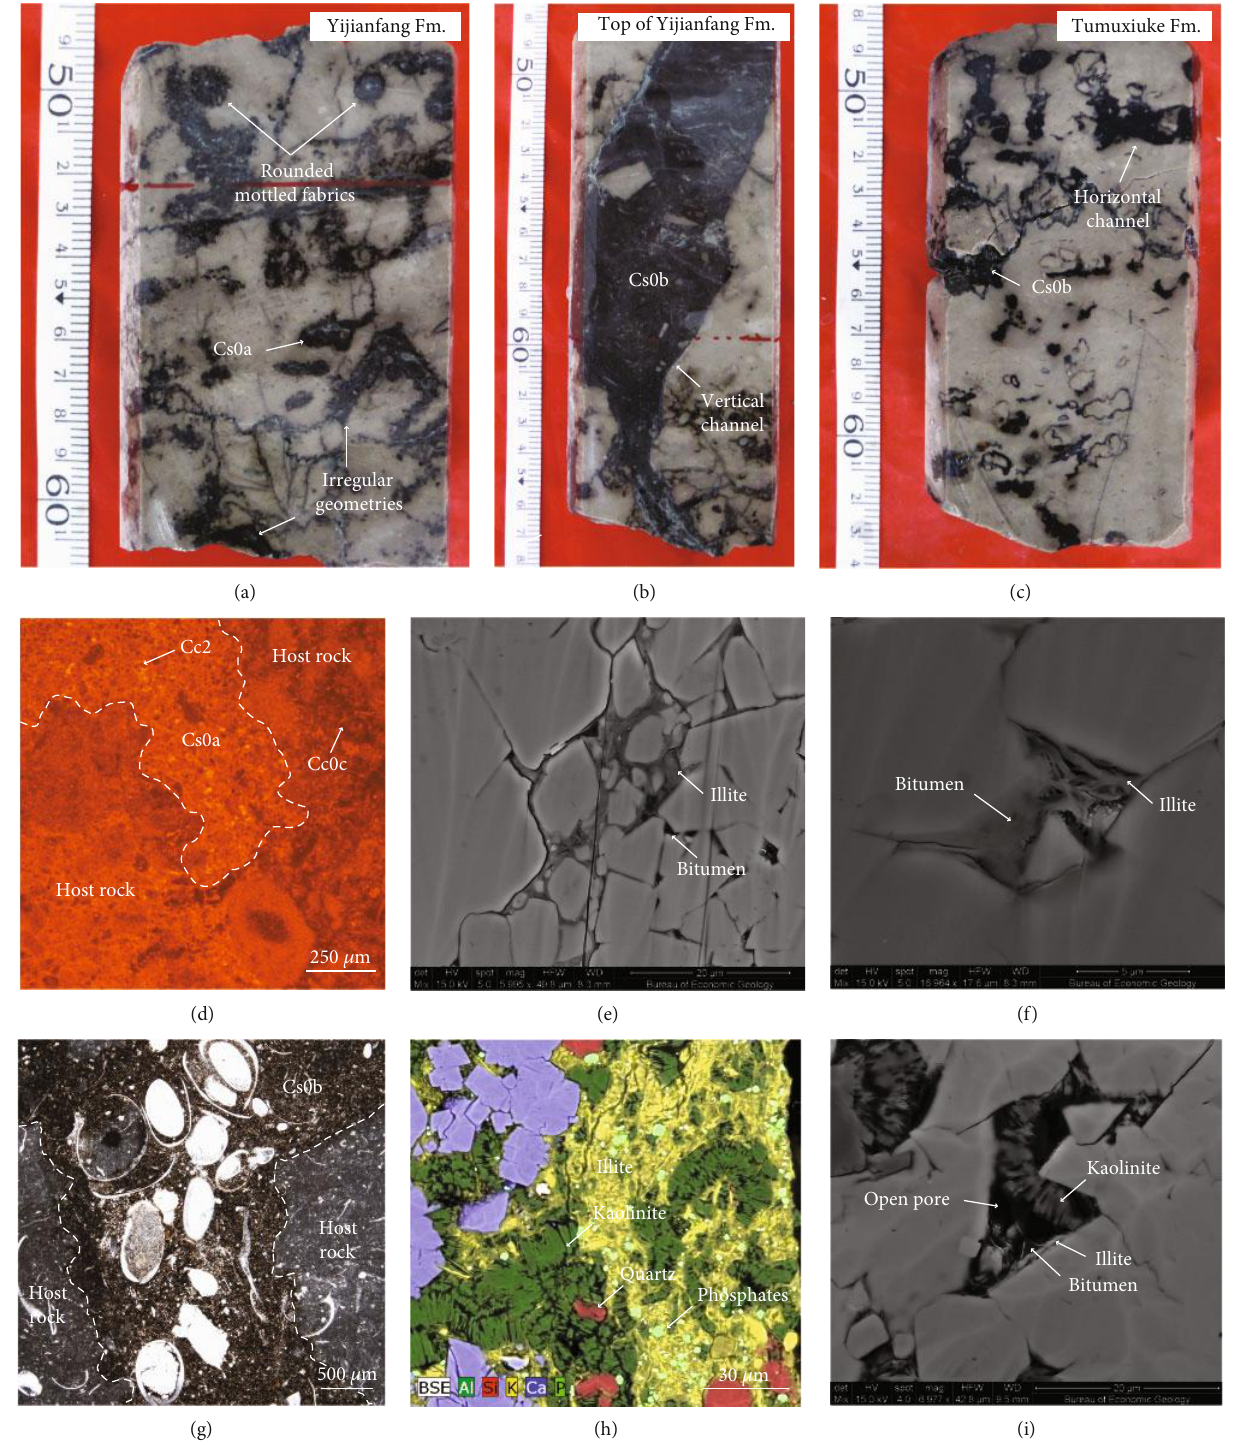
Figure 5: Hand specimen of middle Yijianfang Formation (a), top of the Yijianfang Formation (b), and Tumuxiuke Formation (c) showing rounded and elongated mottle fabrics (channels) fi lled with calcite sediment Cs0. (d) Optical-CL photomicrograph of packstone showing subrounded mottle fabrics fi lled with calcite sediment Cs0a subsequently cemented by Cc2. (e, f) SEM images showing carbonate-rich detritus Cs0a within mottle fabrics. Most of the interparticle porosity is fi lled with illite and/or bitumen (f). (g) Plane light optical photomicrograph of wackestone showing vertical channels fi lled with calcite sediment Cs0b. (h, i) SEM images showing carbonate-rich detritus Cs0b within vertical channels. Most of the interparticle porosity is fi lled with illite, kaolinite, and/or bitumen